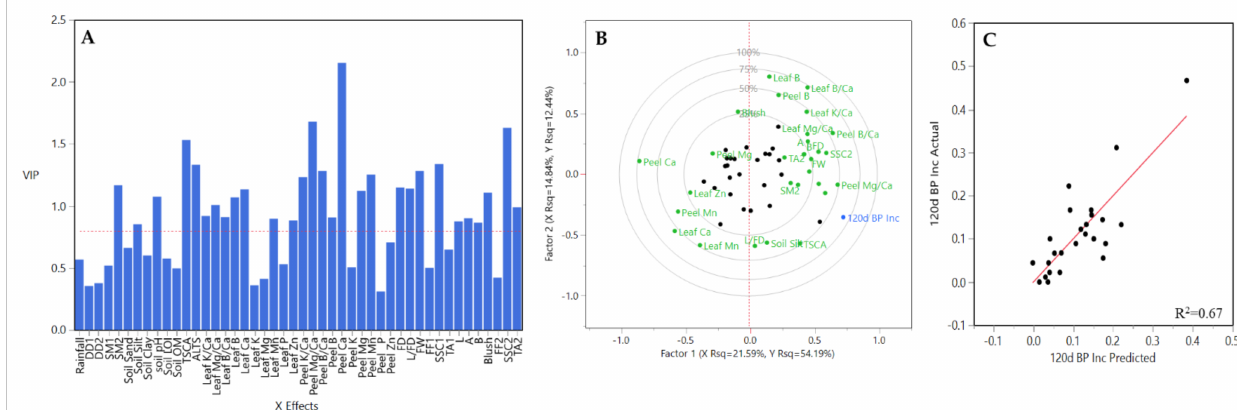
Figure 12. Results obtained from the partial least square (PLS) analysis between BP incidence at 120 DAH and the rest of variables evaluated all three years together for B.9 rootstock in HV and CV. ( A ) Important X variables in the PLS model, ( B ) correlation loading plot, and ( C ) observed values versus PLSR-predicted values for BP. Abbreviations: ALTS: average length terminal shoot; DD1: degree days accumulated from 1st of January to harvest date; DD2: degree days accumulated from 60 days post-bloom; FD: fruit diameter; FF1: flesh firmness at harvest; FF2: flesh firmness after storage; FW: fruit weight; L: length; SSC1: soluble solids content at harvest; SSC2: soluble solids content after storage; SM1: average soil moisture 12 weeks prior to harvest; SM2: average soil moisture from 1st of January to harvest date; TA1: titratable acidity at harvest; TA2: titratable acidity after storage; TCSA: trunk cross-sectional